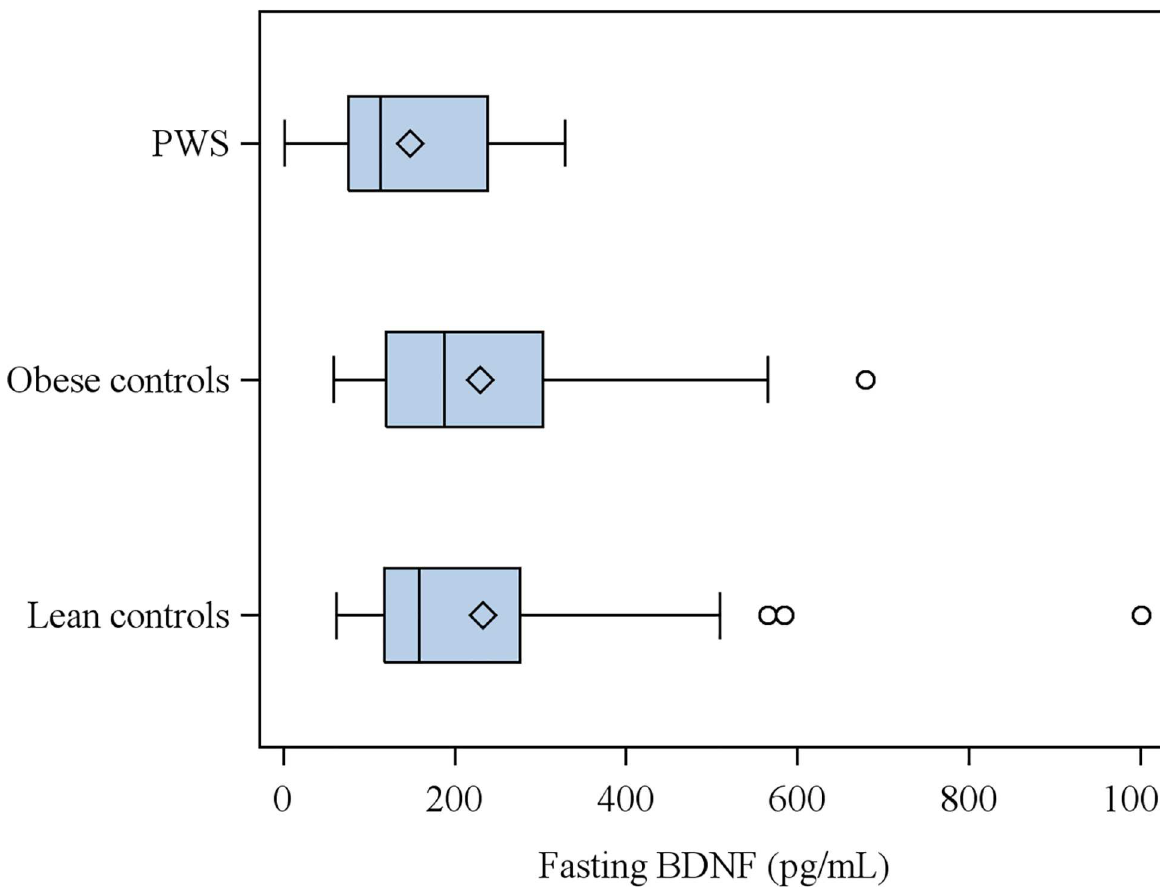
Fig 1. Plasma Brain-derived neurotrophic factor (BDNF) levels in subjects with Prader-Willi syndrome (PWS) and in obese and lean control subjects. PWS subjects vs. obese and lean controls, P = 0.05.